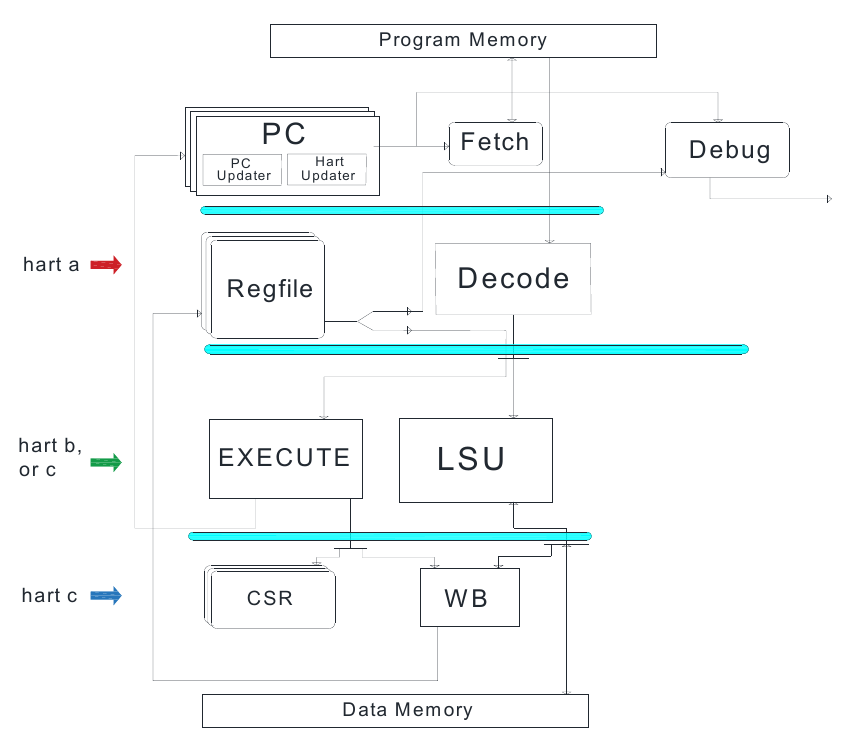
Figure 1. Klessydra T0 core microarchitecture.